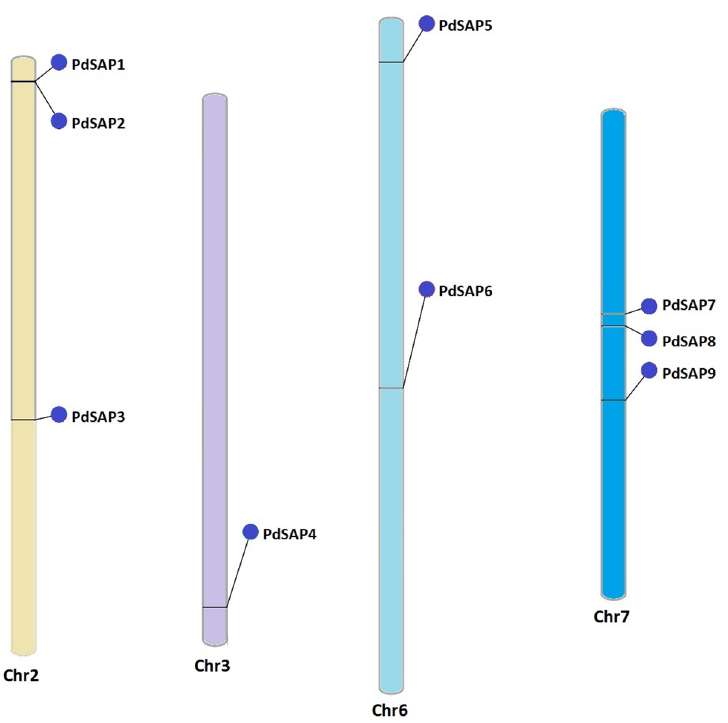
Figure 3. Chromosomal mapping of PdSAP genes. PdSAP genes have been mapped on the chromosomes of P. dulcis . Chromosome numbers are presented below each chromosome. Each chromosome is colored differently.